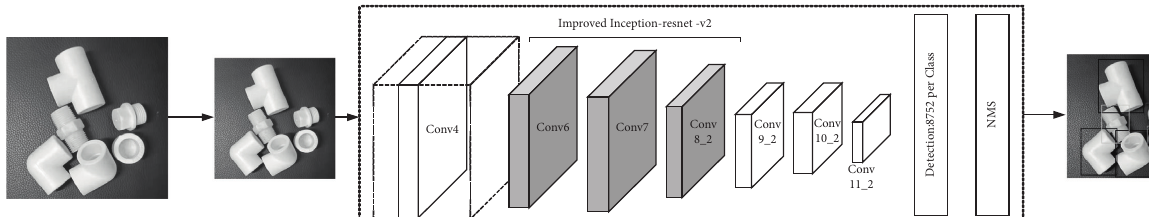
Figure 5: The implementation process of an improved SSD network model.